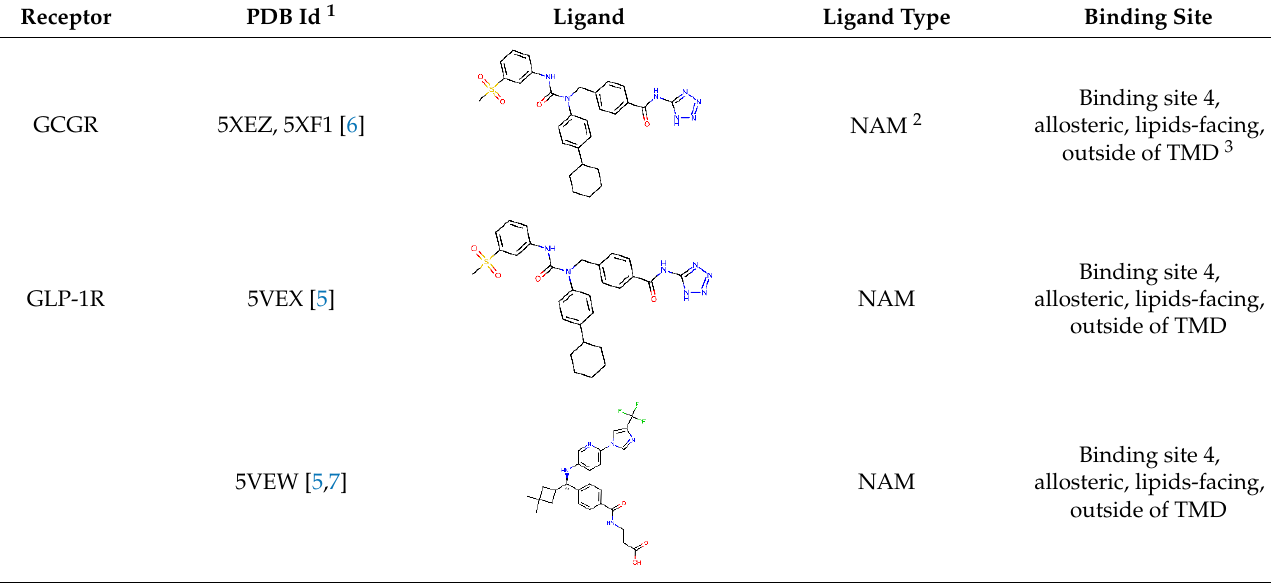
Figure 2. A two-domain activation model of GCGR (left) with a comparison between an active conformation (grey, 5QYZ) with a peptide agonist bound (dark grey) and an inactive conformation (blue-to-red, 5XEZ) with a negative allosteric modulator (blue, shown in sticks). The bottom region of TMD changes significantly in the TMH6 region upon the receptor activation (left). The ECD domain (blue) moves closer to the Z axis of the receptor upon the activation (left), yet without significant changes of its conformation (right, superimposed active—grey, and inactive—blue ECD conformations with a truncated (for visibility) peptide agonist from 5YQZ shown in lines). In contrast to slight ECD changes, the top region of TMD domain (middle) noticeably changes upon the peptide agonist binding. Namely, transmembrane helices TMH1, TMH6, and TMH7 move away from the receptor core. The allosteric binding site of NAMs (left) corresponds to the binding site 4 (I) and 4 (II) of GLP-1R ligands shown in Figure 1. Table 1. Diversity of small-molecule, non-peptide ligands binding to GLP-1R and GCGR receptors.